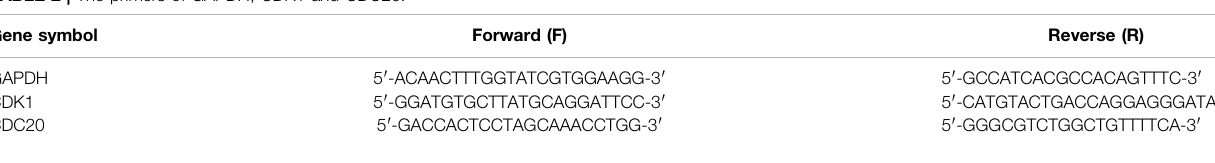
TABLE 2 | The primers of GAPDH, CDK1 and